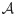
Average proxy A-distance (solid line) with the standard error of the mean (line thickness) for all six conditions.The proxy A-distance is plotted against the total number of test patches. Condition 1 provided the lowest proxy A-distance (largest similarity between data sets). Conditions 5 and 6 provided the highest proxy A-distance (largest dissimilarity between data sets).